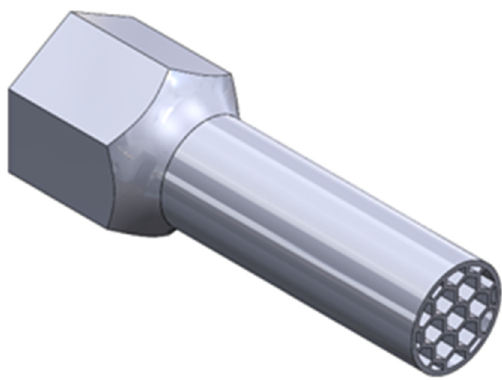
Figure 2. A view of the ‘Kagome-structured’ test sample ( left ) and the single cell ( right ) from which the structure was assembled (PS_Samples).